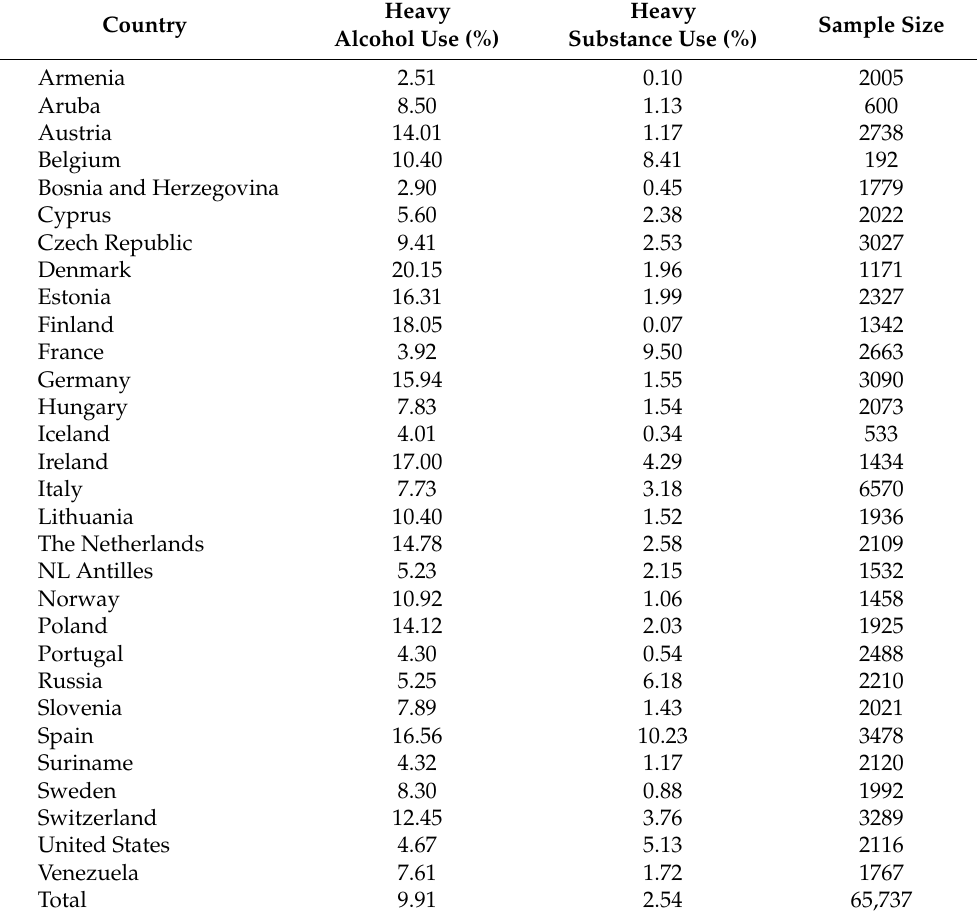
Table A1. Percentage of adolescents, ages 12–18, reporting heavy alcohol use and heavy substance use, by country, ISRD-2,